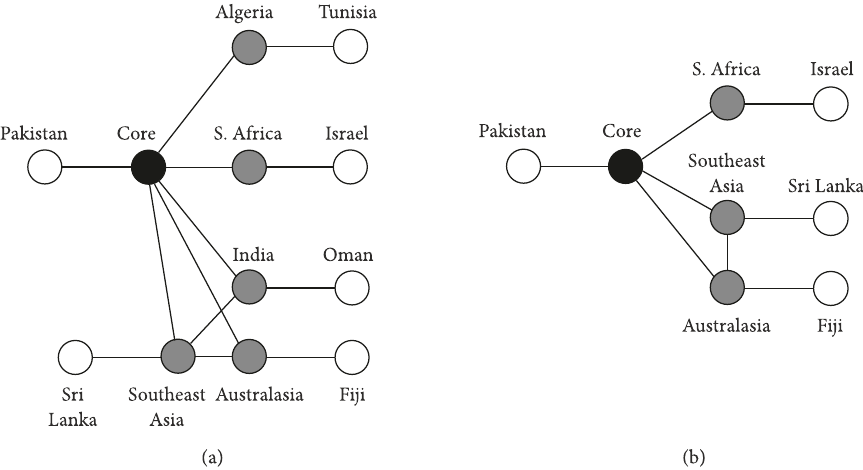
Figure 8: (a) The removal of the Australasia-India edge yields a new pair of F-twin subgraphs; (b) resulting CSP structure.